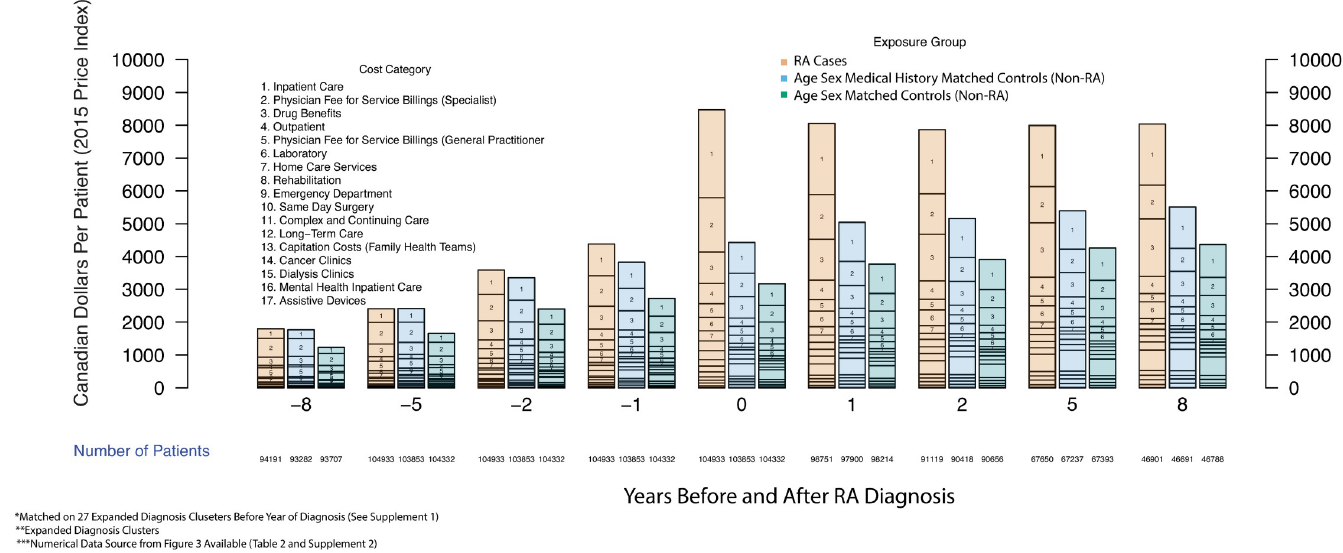
Fig 3. Annual per-patient health care costs over time grouped by year before and after rheumatoid arthritis diagnosis (public payer’s perspective). X-axis: Years before and after RA diagnosis, Y-axis: Canadian Dollars Per Patient (2015 Price Index).